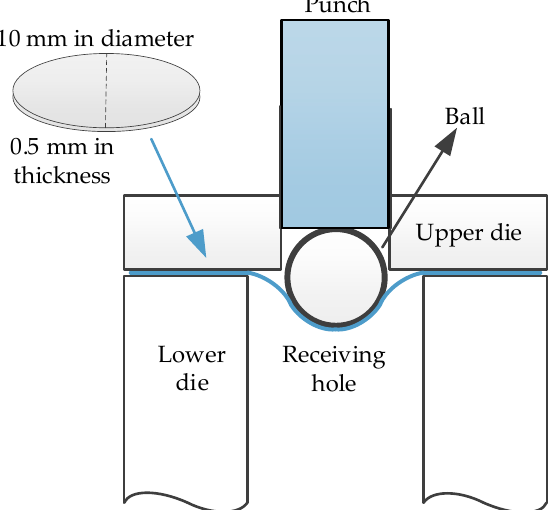
Figure 2. The schematic diagram of the small punch test (SPT).